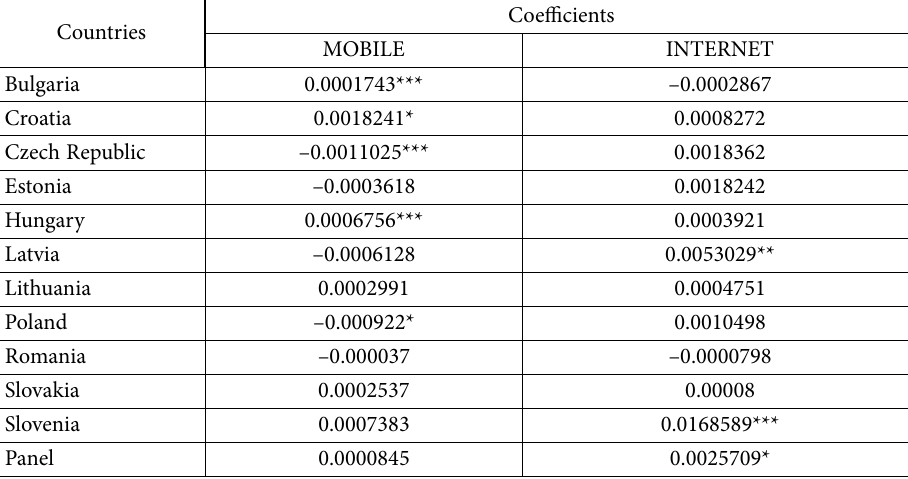
Table 7b. Results of cointegration coefficients’ estimation (Model